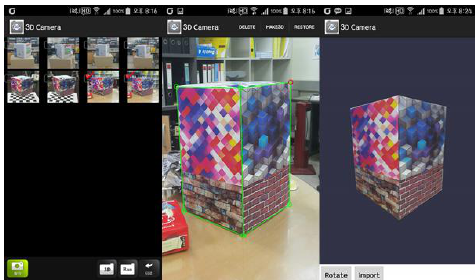
Figure 5. 3D building modelling application UI